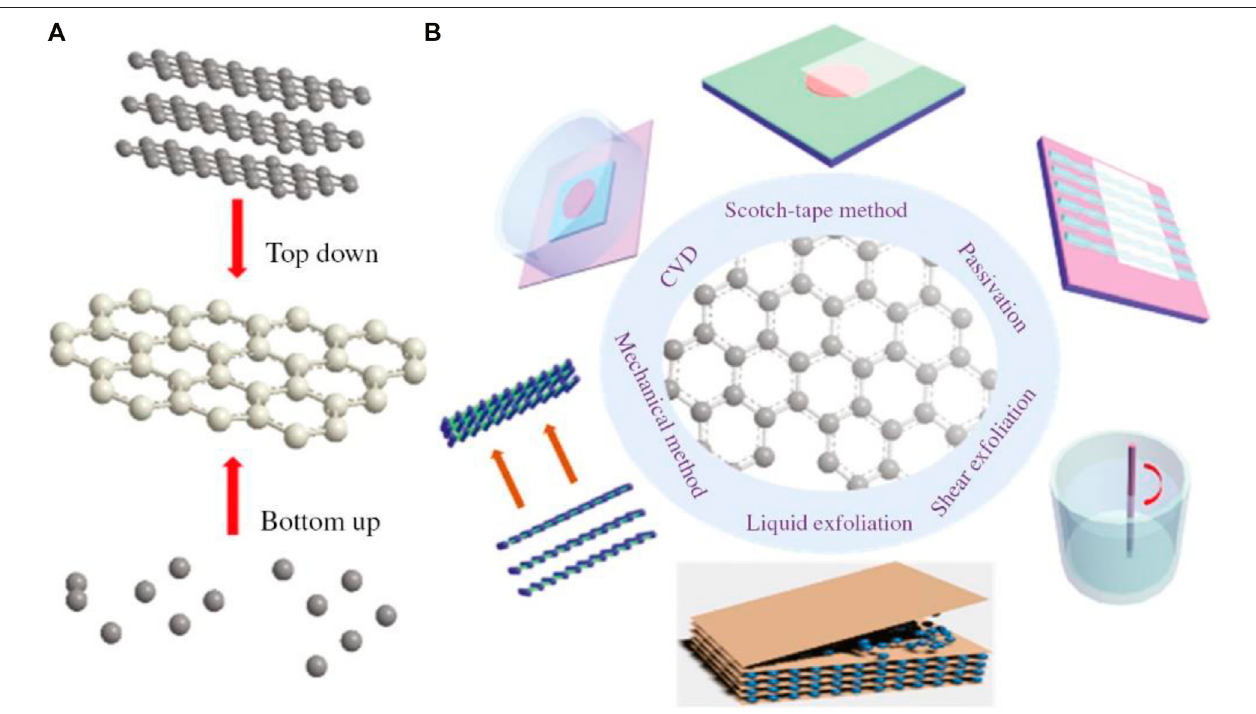
FIGURE 2 | Synthesis methods of 2-dimensional Nanomaterials. (A) There are two primary strategies: top-down exfoliation and bottom-up growth. (B) A series of different extensive fabrication techniques to synthesize 2D Nanomaterials (Li, Wang, Yin, Lewis, & Wang, 2020).